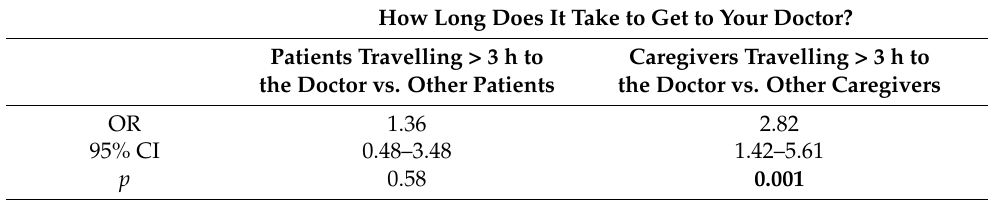
Table 6. The impact of the time of travelling to a PKU-treating centre before the pandemic on believing that remote visits are a replacement for direct contact with a PKU